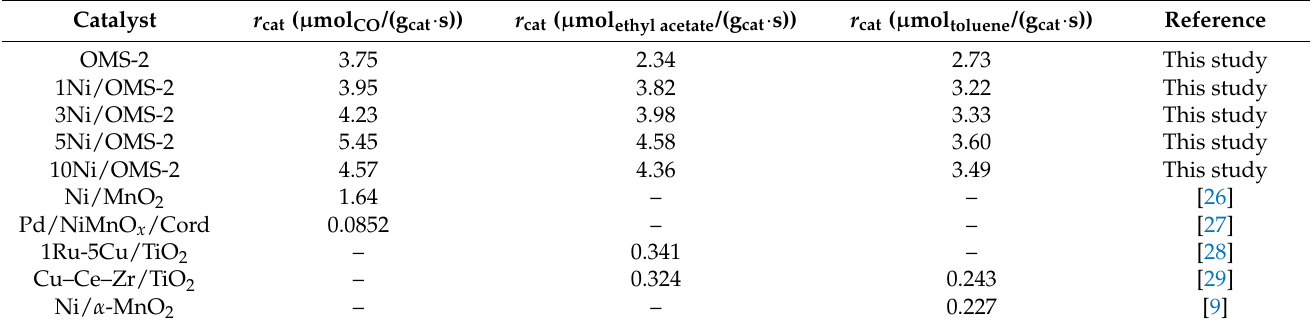
Table 4. A comparison on specific reaction rates for CO at 145 ◦ C, ethyl acetate at 220 ◦ C, and toluene at 275 ◦ C over the catalysts reported in the present work and the